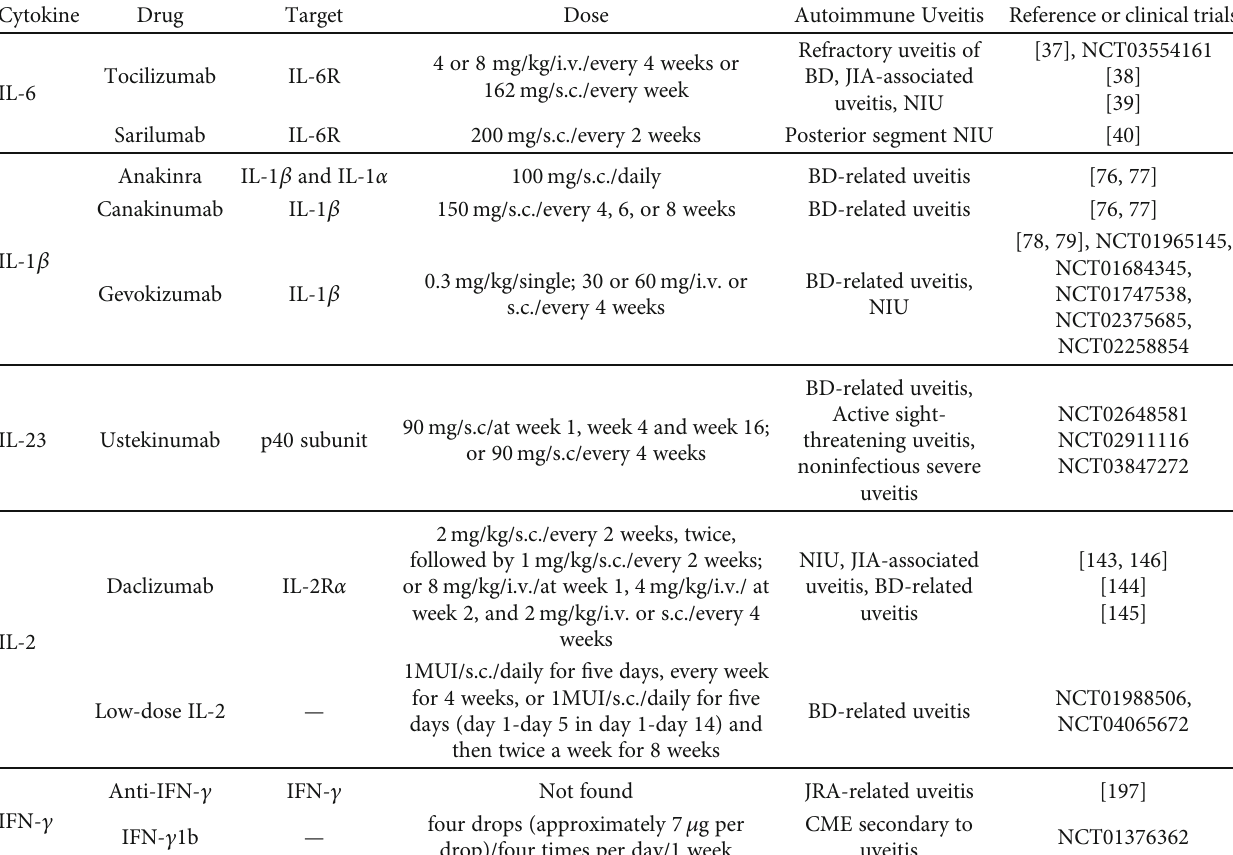
Table 1: The clinical trials of agents target Th17 di ff erentiation-associated